Question: What does this figure show? Answer in one sentence.
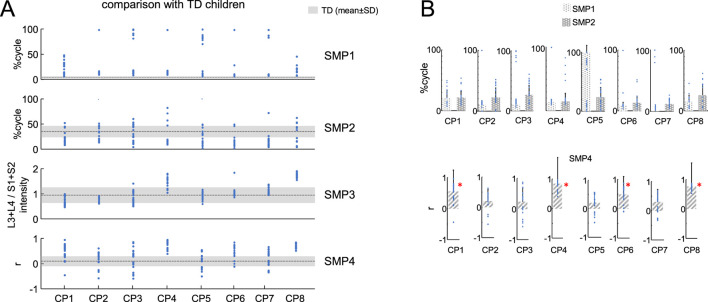
Answer: Spatiotemporal topographic map parameters across eight children with CP. (A) Aggregate summary metrics for all eight evaluated children with CP plotted against the normative baseline range of TD peers (grey shading, mean + SD). Circles display the distribution of values across all performed strides. (B) Statistical evaluation of segmental activation structure across children. The absence of asterisks over the temporal timing parameters (upper panel) indicate the absence of a statistically significant separation (Watson–Williams test, p > 0.05) between peak lumbar (SMP1) and sacral (SMP2) activation hotspots determined via circular statistics. Asterisks on the waveform similarity index (SMP4, lower panel) indicate that the mean Fisher z-transformed correlation coefficients between the lumbar (L3+L4) and sacral (S1+S2) segment waveforms are significantly greater than zero (one-tailed t-test, p < 0.05), confirming the presence of lumbosacral coactivation.